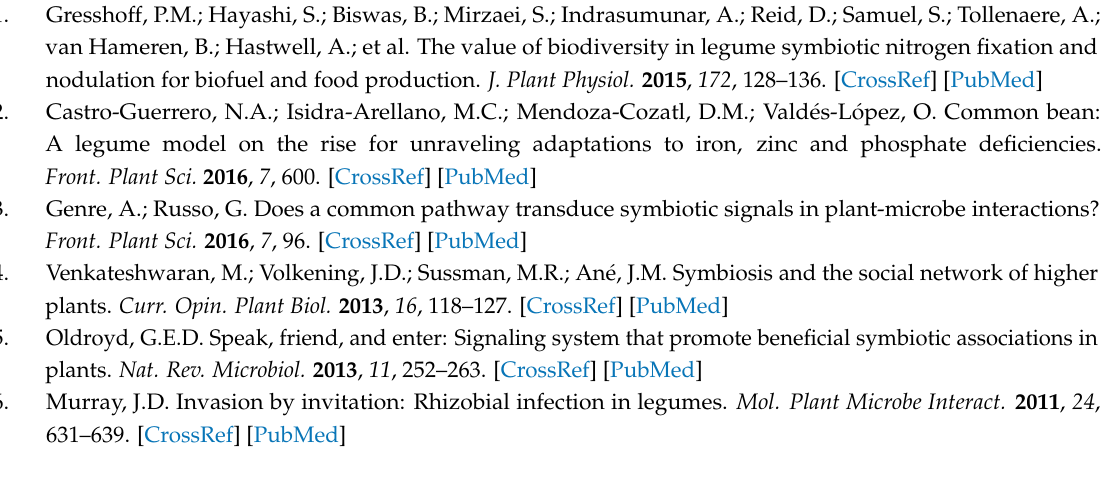
Figure S1 Expression profile of AGO5 from common bean and soybean; Figure S2 Domain and phylogenetic analysis of AGO5 from common bean and soybean; Figure S3 Expression levels of PvAGO5 in responses to mock or rhizobia inoculation; Figure S4 Expression levels of GmAGO5 in responses to mock or rhizobia inoculation; Figure S5 AGO5 -RNAi nodules are small and white; Figure S6 Expression level of PvCYCLOPs in AGO5 -RNAi roots; Table S1 Primers used for qRT-PCR